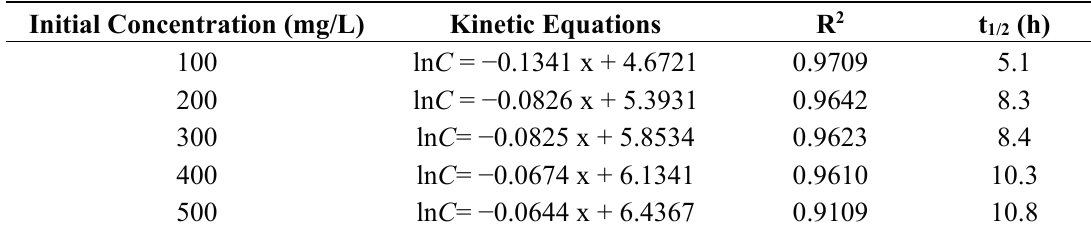
Table 2. Kinetics of DBP degradation by strain